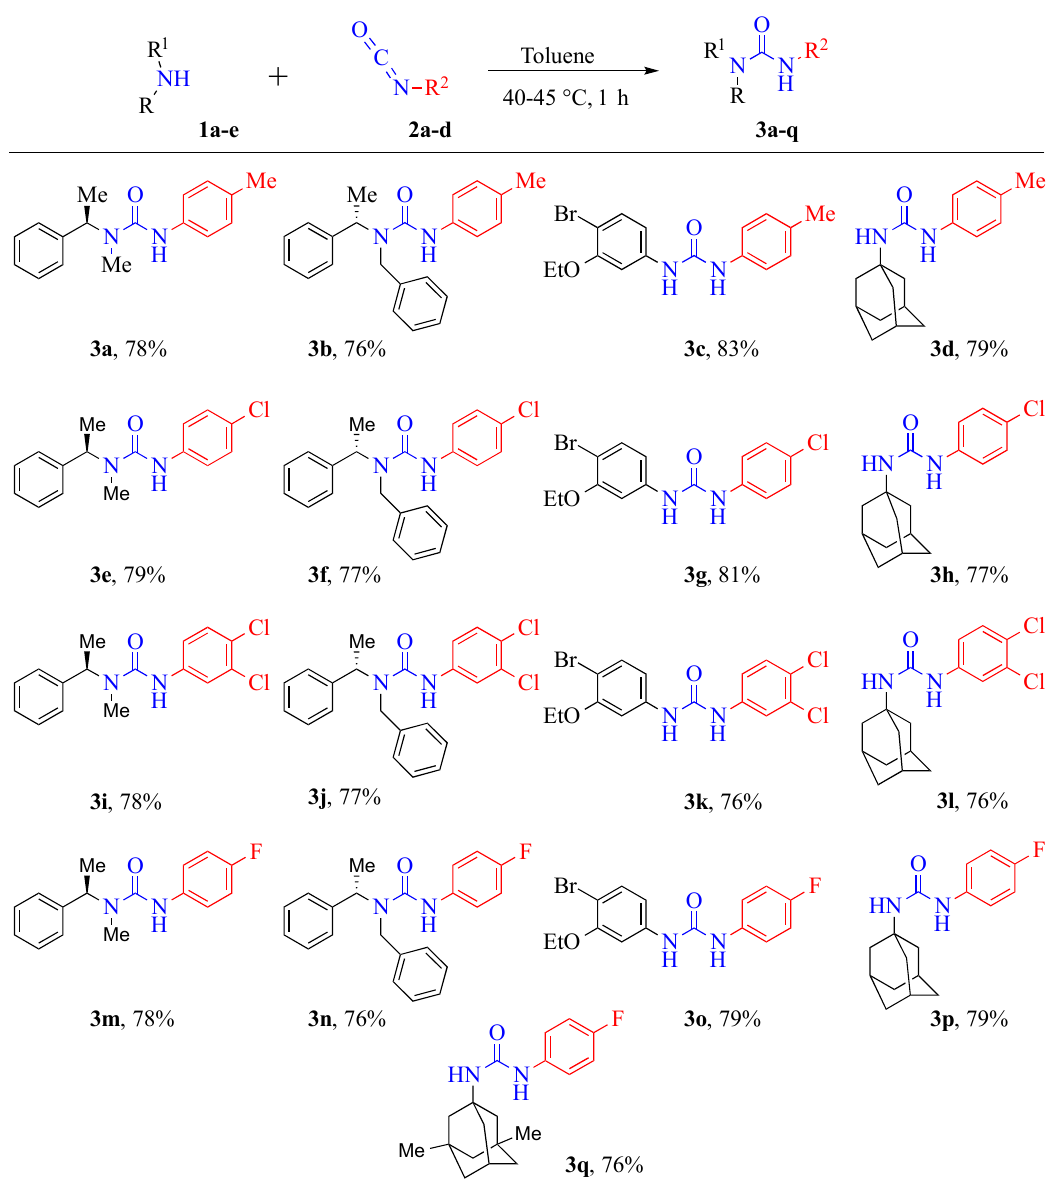
Scheme 1. Synthesis of urea derivatives ( 3a–q )